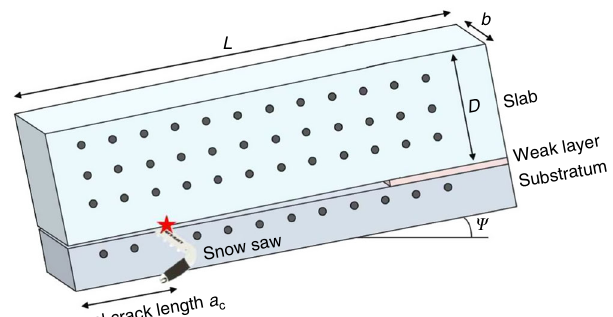
Fig. 4 Illustration of the experimental set-up of the Propagation Saw Test (PST). After reaching the critical crack length (red star), the crack propagates along the weak layer. Black markers are inserted in the slab and the substratum to track their positions using Particle Tracking Velocimetry (PTV)